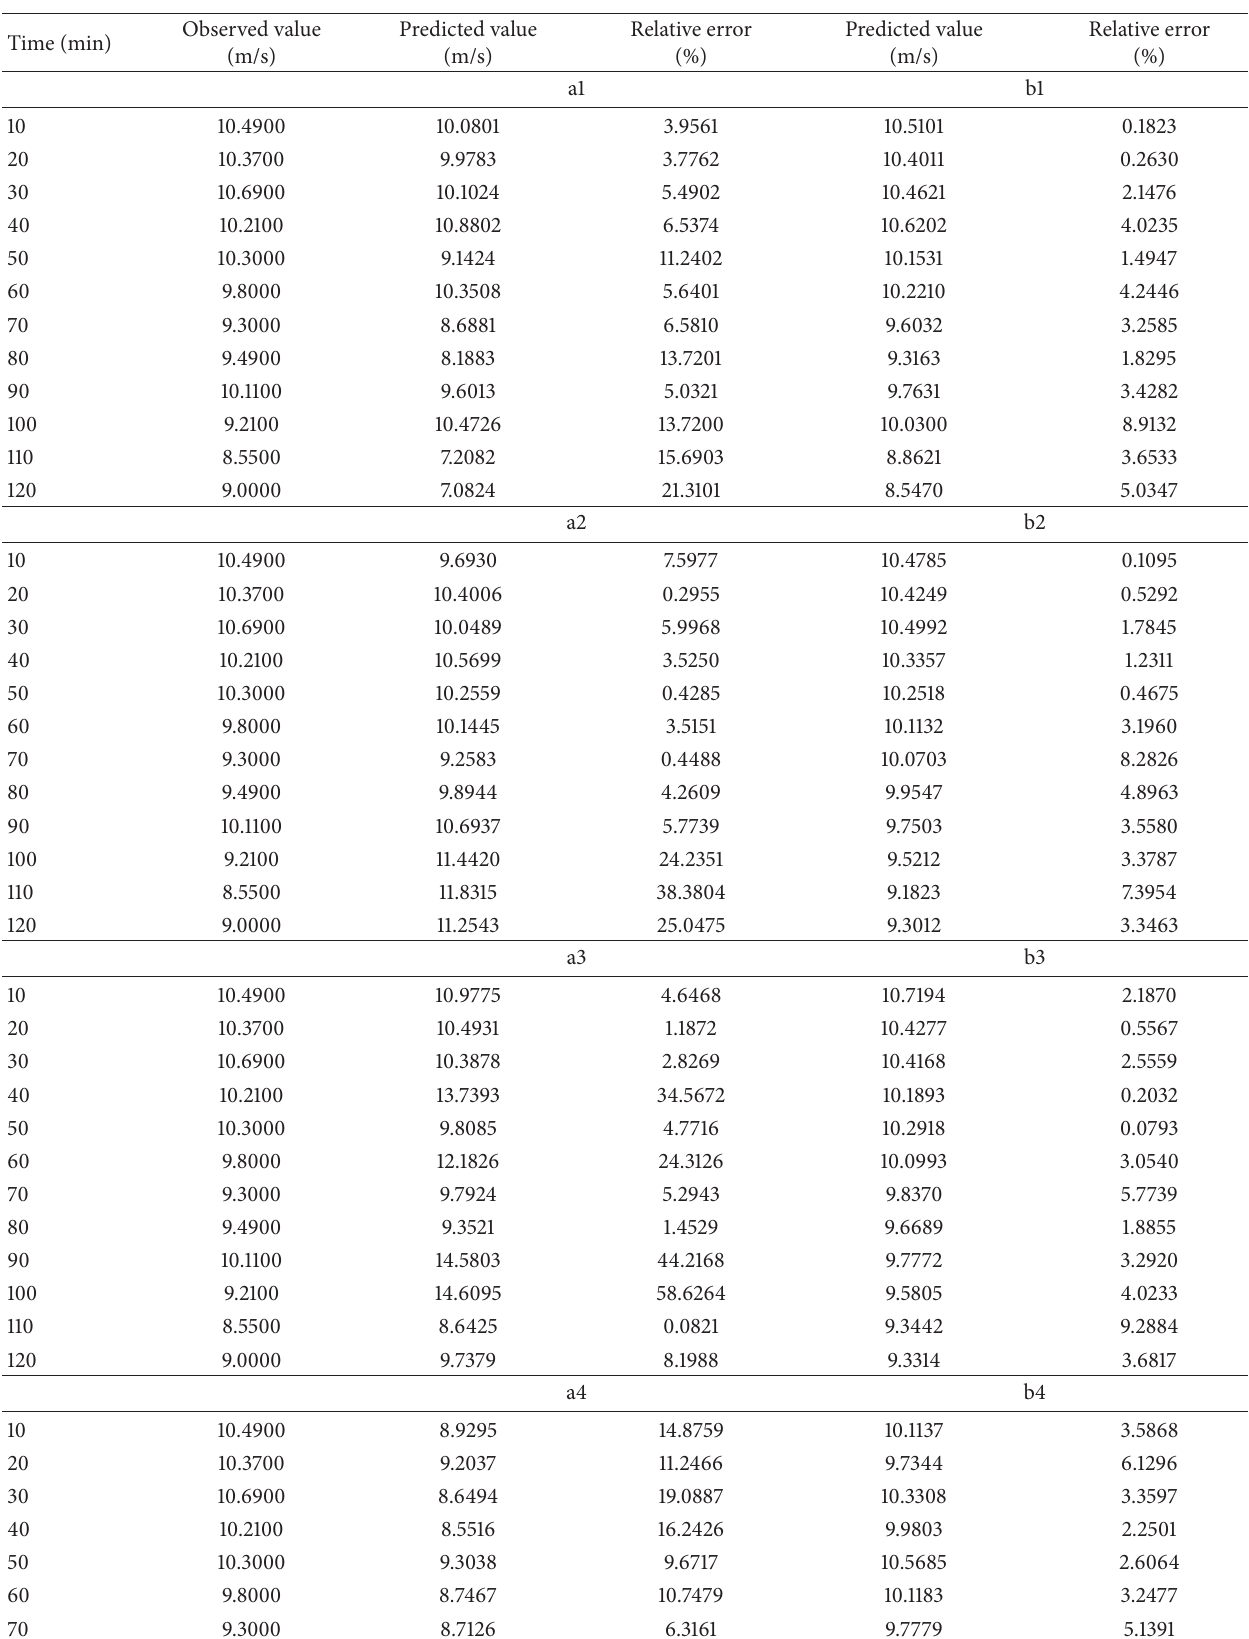
Table 7: Observed wind speed data and predicted